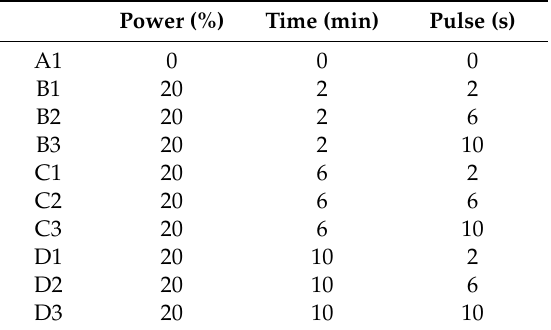
Table 1. Combinations of power, duration of the treatment and